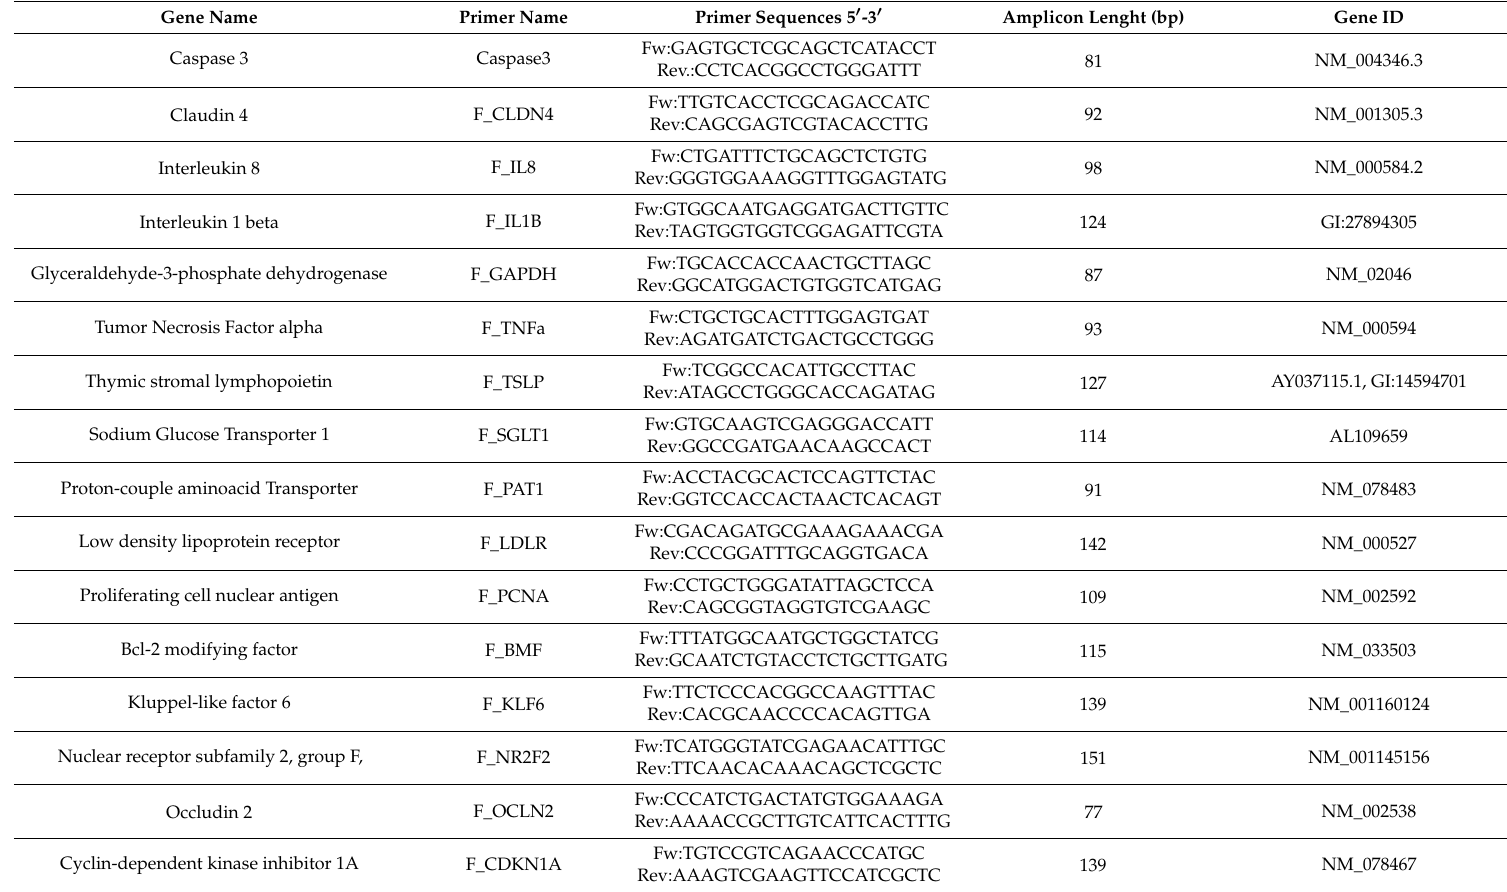
Table 2. Sequences of primers used for